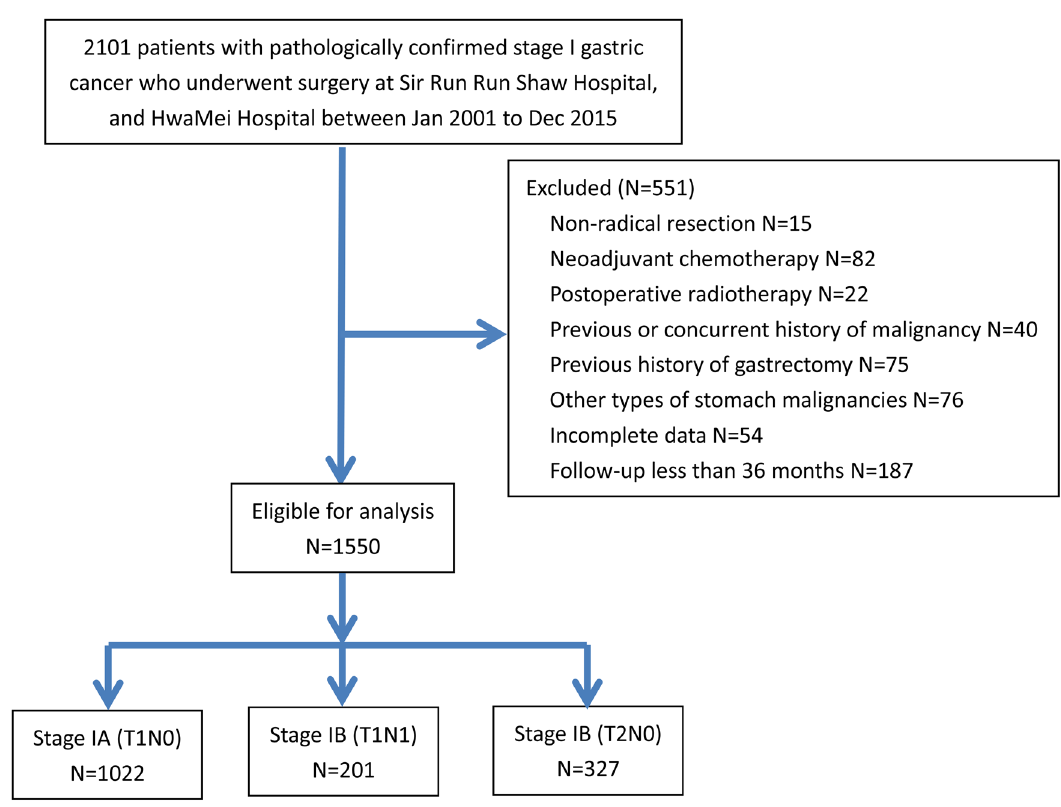
Figure 1: Flowchart of the study